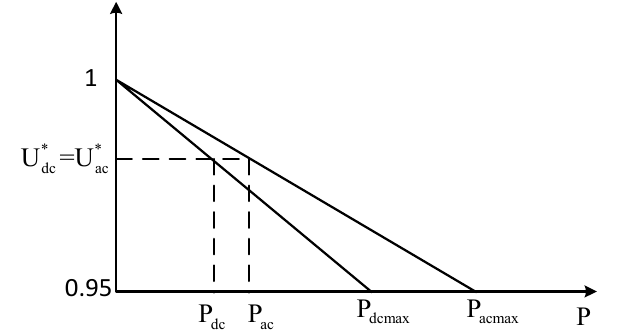
Appl. Sci. 2019 , 9 , x Figure 3. Scheme of entire network droop control. Figure 3. Scheme of entire network droop control.